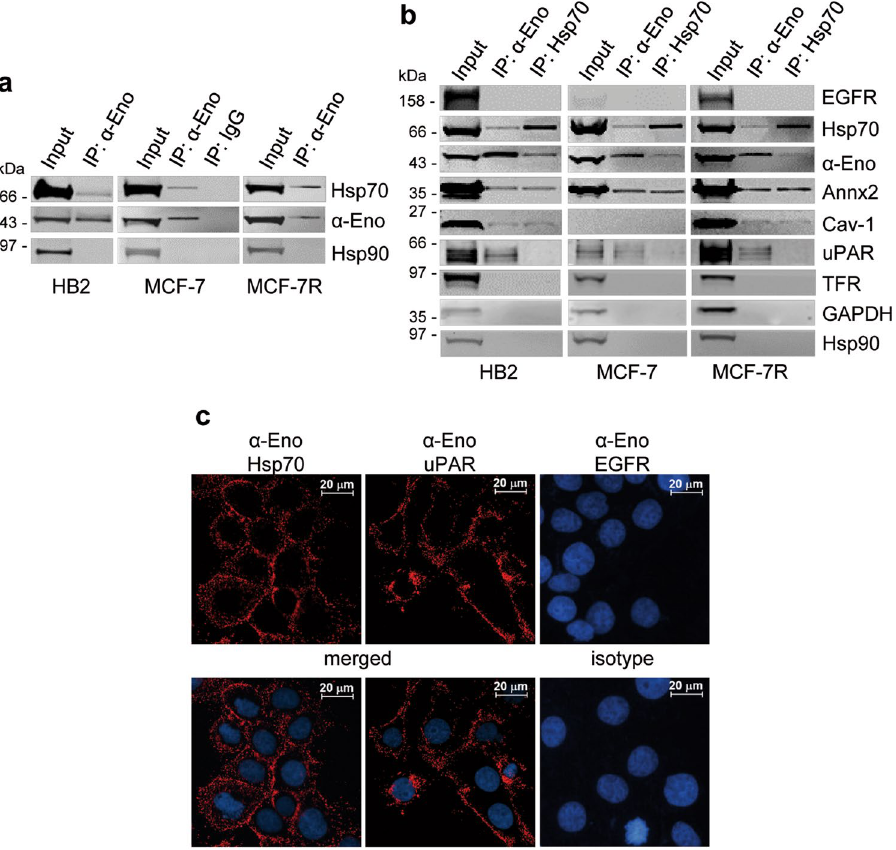
Figure 4. Interaction between Hsp70 and alpha-enolase. ( a ) Association of endogenous Hsp70 and alpha- enolase proteins in the cytoplasmic fraction of HB2, MCF-7 and MCF-7R cells. Cytoplasmic extracts were immunoprecipitated with anti-alpha-enolase monoclonal antibody (IP: α -Eno) or a pre-immune isotype- matched antibody (IP: IgG), then analysed by immunoblotting using anti-Hsp70 polyclonal antibody, anti- alpha-enolase polyclonal and anti-Hsp90 monoclonal antibody. Input represents 4% of the cell extract used for each IP sample. Hsp70 was specifically co-immunoprecipitated with alpha-enolase in the three cell lines. ( b ) Association of endogenous Hsp70 and alpha-enolase proteins in the plasma membrane fraction of HB2, MCF-7 and MCF-7R cells. Plasma membrane fractions were immunoprecipitated with anti-alpha-enolase monoclonal antibody (IP: α -Eno) or anti-Hsp70 monoclonal antibody (IP: Hsp70). Immunoprecipitated complexes were analysed by immunoblotting for the presence of the indicated proteins. Annx2, Cav-1 and uPAR were used as positive controls for alpha-enolase interactions. No co-precipitation of EGFR, TFR, GAPDH or Hsp90 was observed with either Hsp70 or alpha-enolase, while Annx2 and Cav-1 were specifically co-immunoprecipitated with both proteins. Note that Cav-1 expression is undetectable in the MCF-7 plasma membrane fraction compared to the other cell lines. Hsp70 was specifically co-immunoprecipitated with alpha- enolase, and, similarly, alpha-enolase was specifically co-immunoprecipitated with Hsp70. Input represents 6% of the cell extract used for each IP sample. ( c ) Representative images of PLA assay detecting the proximity of surface-localized alpha-enolase and Hsp70. HB2 cells were live-stained with alpha-enolase-specific antibody together with anti-Hsp70 ( α -Eno, Hsp70), anti-uPAR ( α -Eno, uPAR), anti-EGFR ( α -Eno, EGFR) and nuclei counterstained with DAPI (blue). A positive amplified signal (red) indicated that alpha-enolase and either Hsp70 or uPAR (positive control) were co-located within 40 nm, while no signal was obtained after incubation with either anti-EGFR or isotype-matched antibody (right panels). Results are representative of three independent experiments with comparable